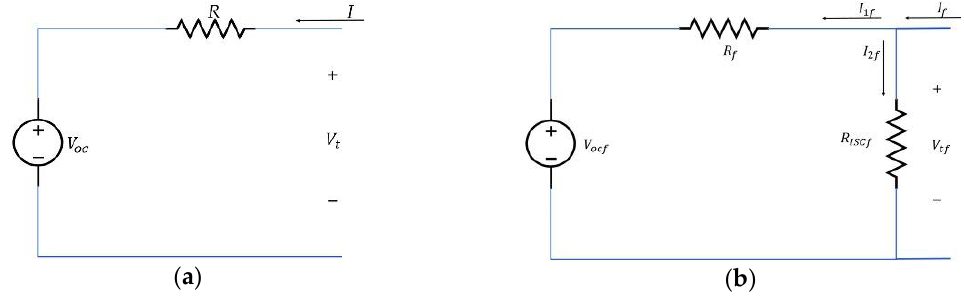
Figure 2. Schematic diagram of equivalent circuit models: ( a ) normal battery; ( b ) battery with ISCr.